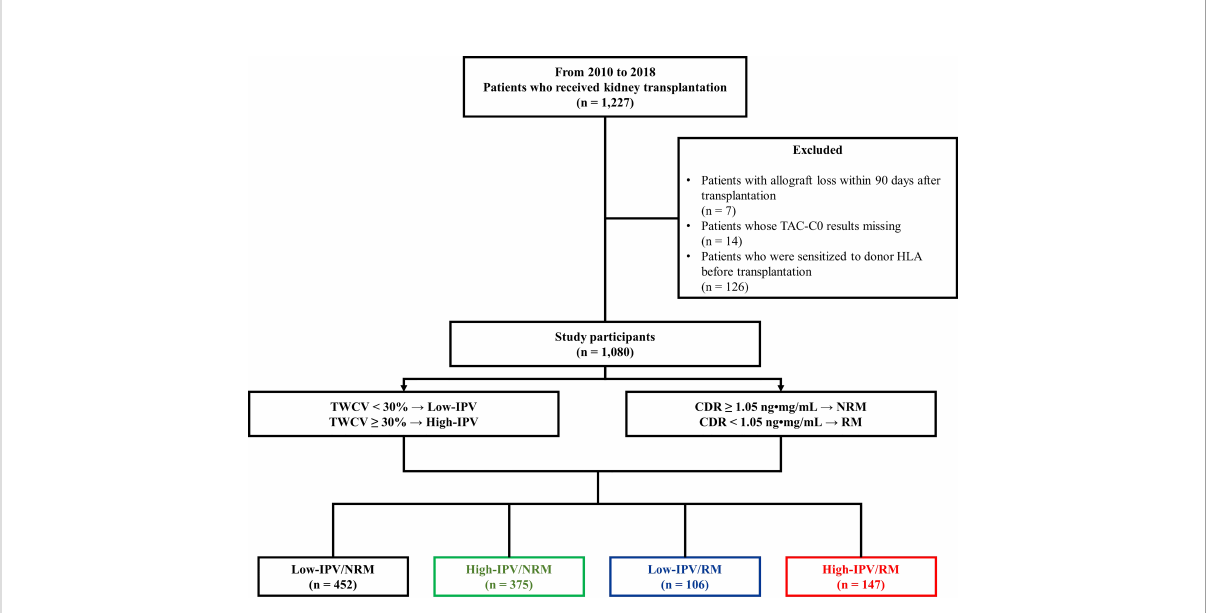
FIGURE 1 Study design. Between January 2010 and December 2018, 1,080 patients were included in the study. Based on a TWCV of 30%, the patients were classi fi ed into high- or low-IPV groups. The RM and NRM groups were classi fi ed based on the CDR 1.05 ng (cid:129) mg/mL. Finally, the patients were classi fi ed into four groups according to their TAC-IPV and RM/NRM status. CDR, concentration-to-dose ratio; HLA, human leukocyte antigen; IPV, intra-patient variability; NRM, non-rapid metabolizer; RM, rapid metabolizer; TAC-C0, tacrolimus trough level; TWCV, time- weighted coef fi cient